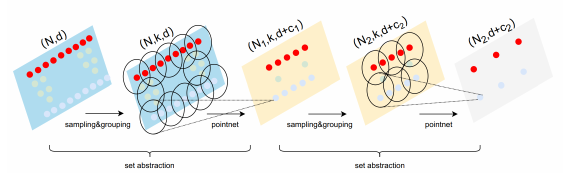
Figure 3. Set abstraction. N is the number of input points, d is the coordinate dimension of points, and c is the intensity.